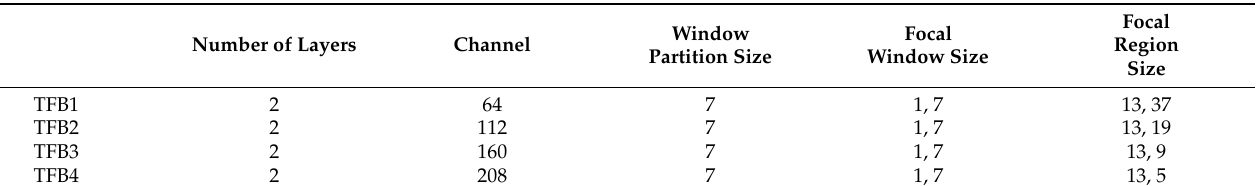
Table 2. Model configurations for Transformer Fusion Block network. TFB1 denotes the Transformer Fusion Block in the first row.